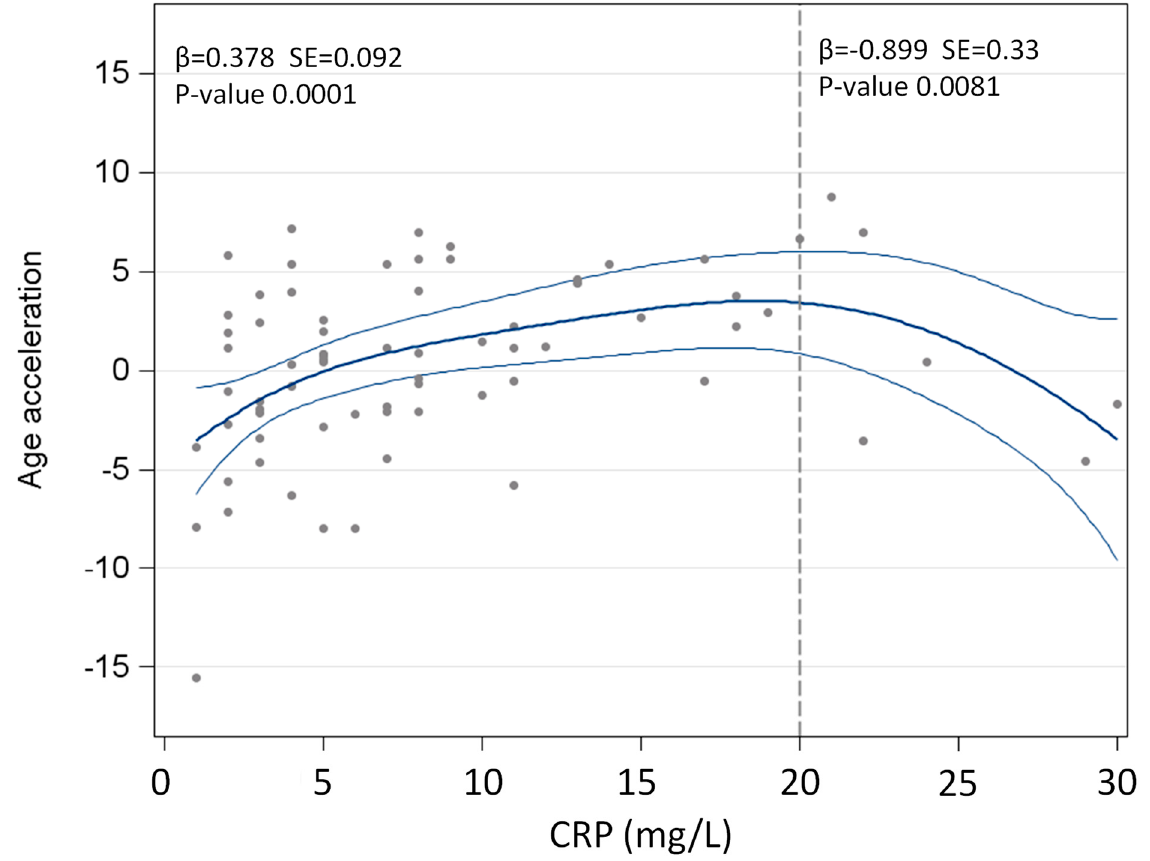
Figure 3. Relationship of epigenetic age acceleration at pre-BWRP with CRP concentrations, evaluated by restricted cubic splines.